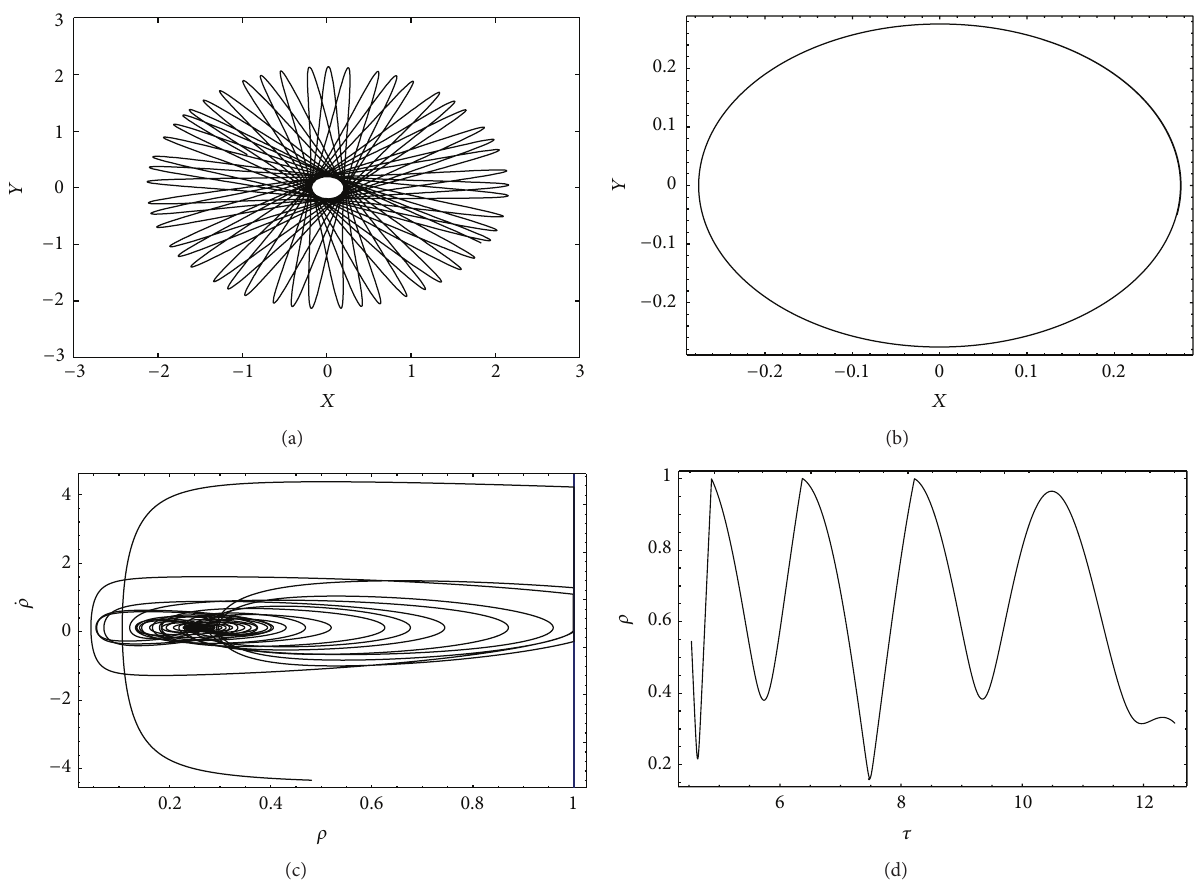
Figure 5: Control result at 𝜔 = 2.1 . (a) The trajectory of rotor center before control; (b) the trajectory of rotor center after control; (c) the phase portrait of rotor center by impulsive control; (d) the time response of radial displacement by impulsive